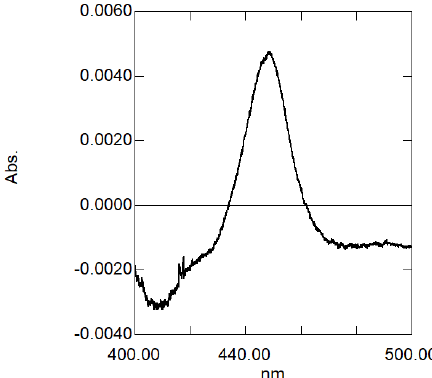
Figure 5. The reduced carbon monoxide (CO)-di ff erence spectrum of the microsomal fraction of yeast harboring the Pf-49487 expression